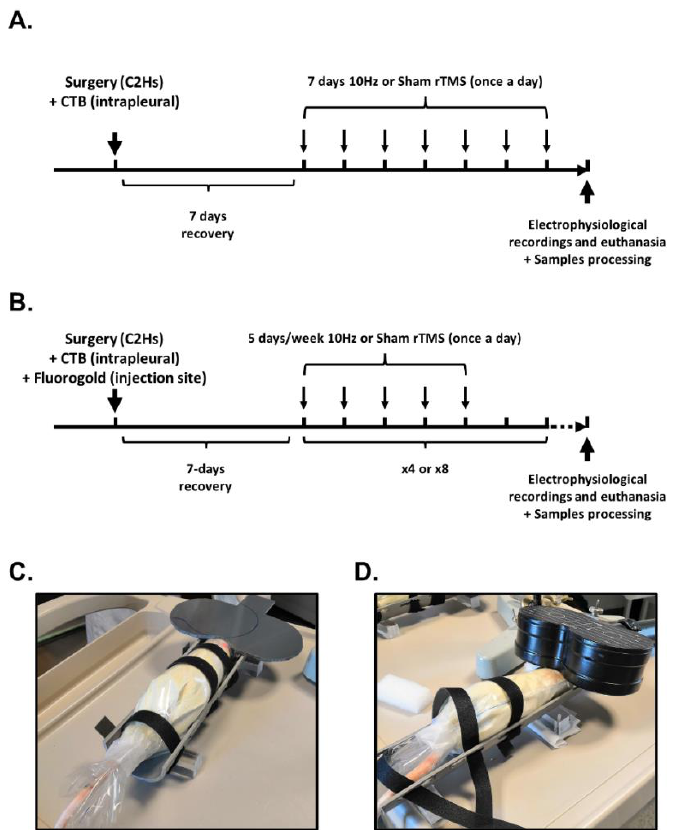
Figure 1. Protocols for 10 Hz or Sham rTMS following C2 spinal cord hemisection: ( A ) rTMS protocols for 7-day-treated groups; ( B ) rTMS protocols for 1-month- and 2-month-treated groups; ( C ) image of rat receiving Sham rTMS protocol; ( D ) image of rat receiving 10 Hz rTMS protocol.